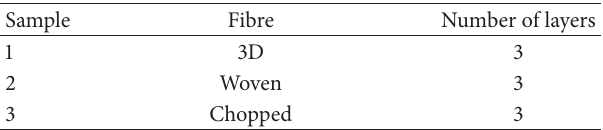
Figure 1: Open mould filled up with fibre glass in hand lay-up